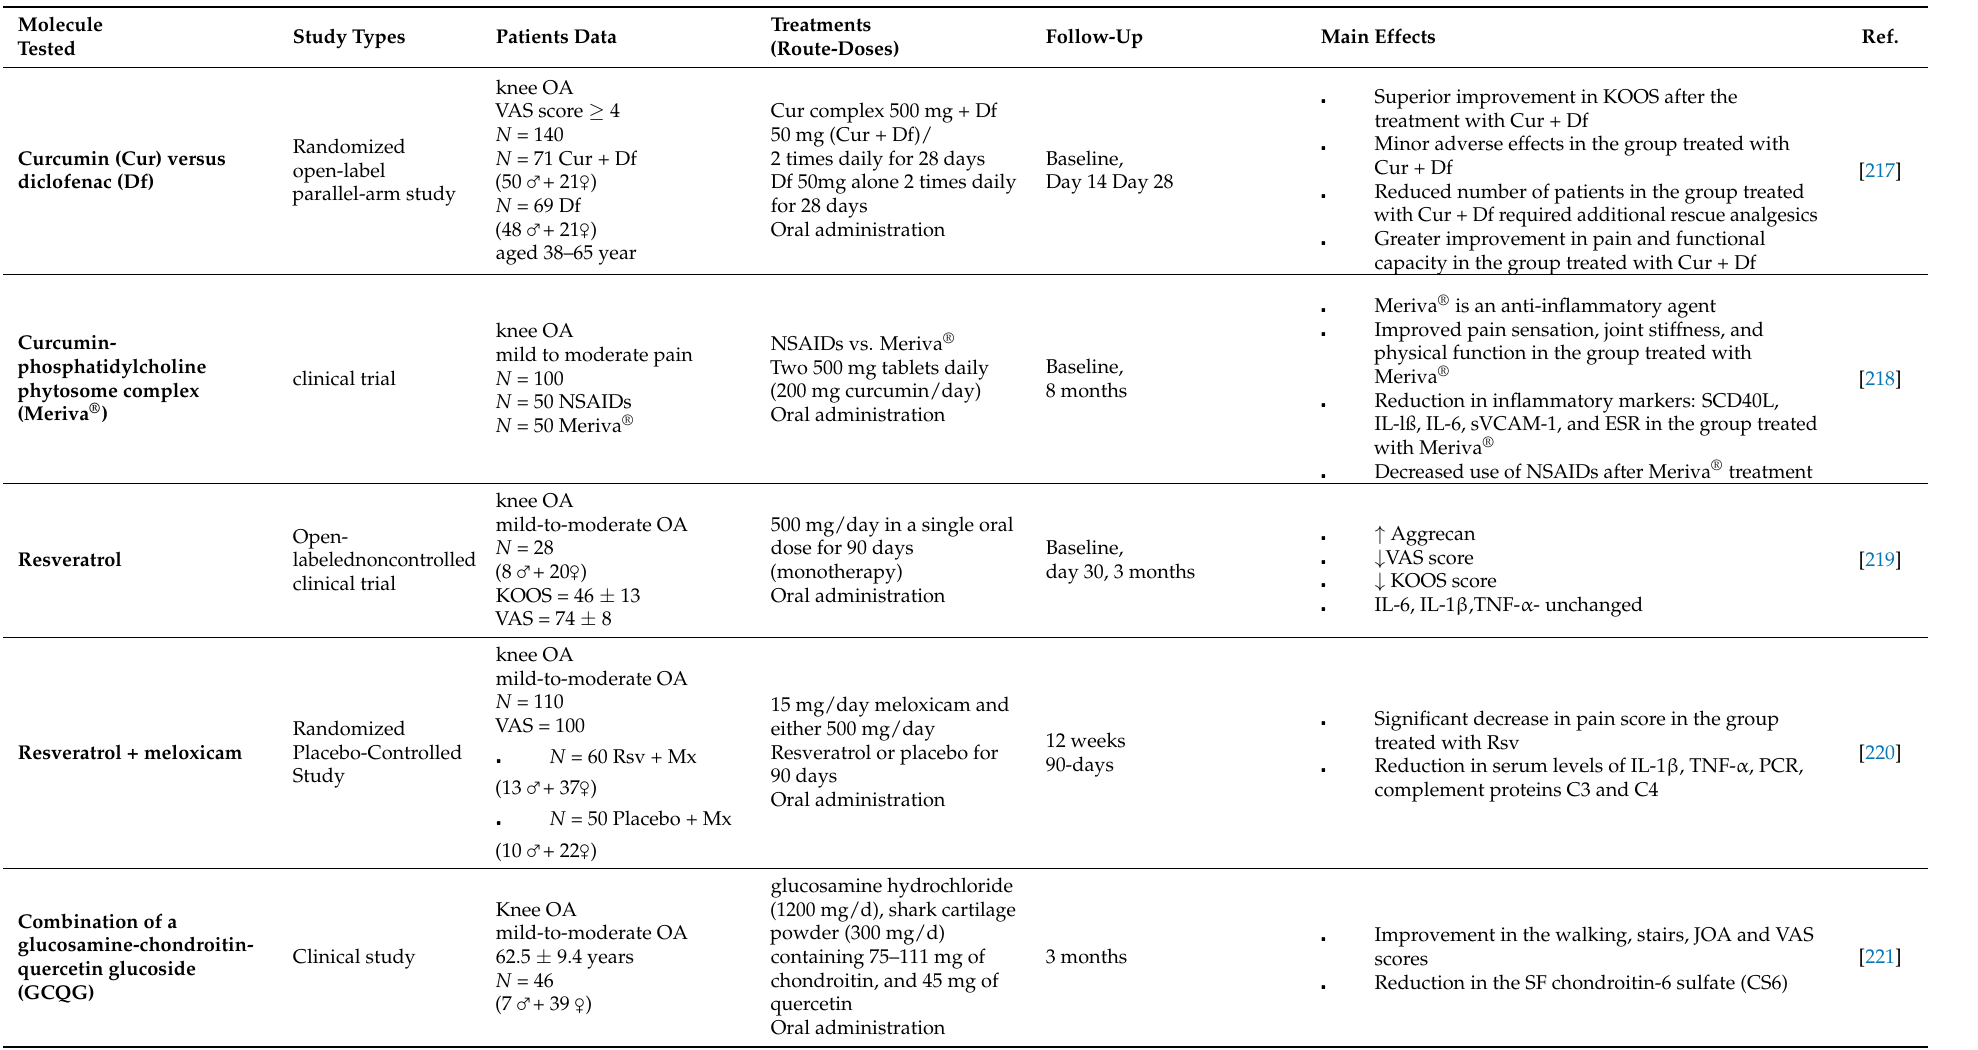
Table 3. Clinical studies of PPs on OA